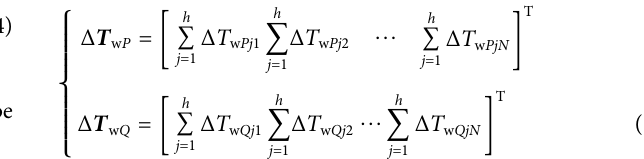
Frontiers in Energy Research |